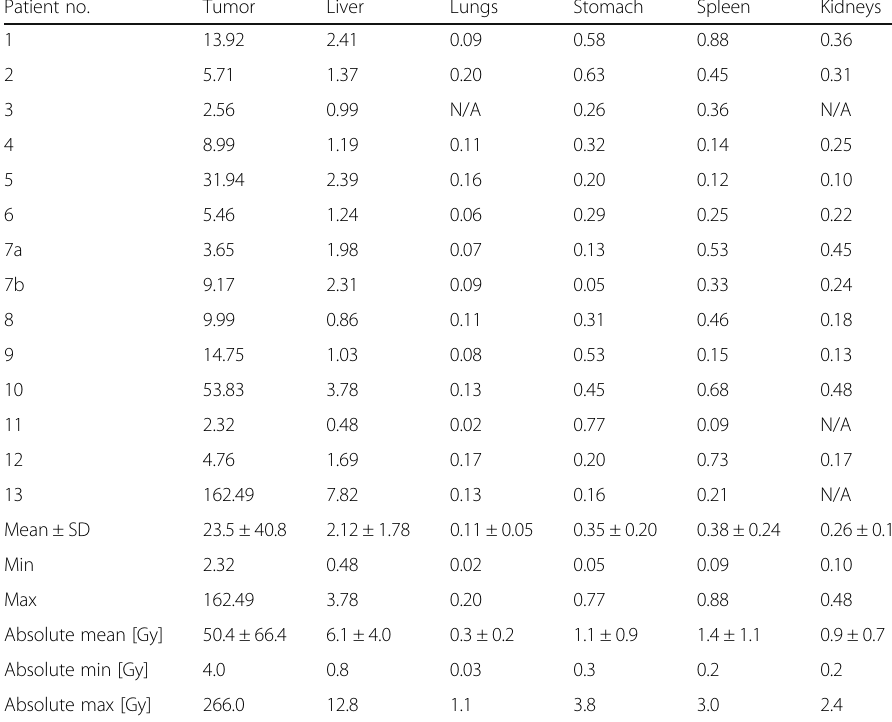
Table 2 Normalized absorbed doses per injected activity (in mGy/MBq) in tumors and organs at risk for each patient, and their average over the entire dataset. The standard deviation (± SD) and the minimum and maximum normalized doses are also reported. Additionally, the absolute mean (± SD), minimum, and maximum absorbed doses are reported Patient no.